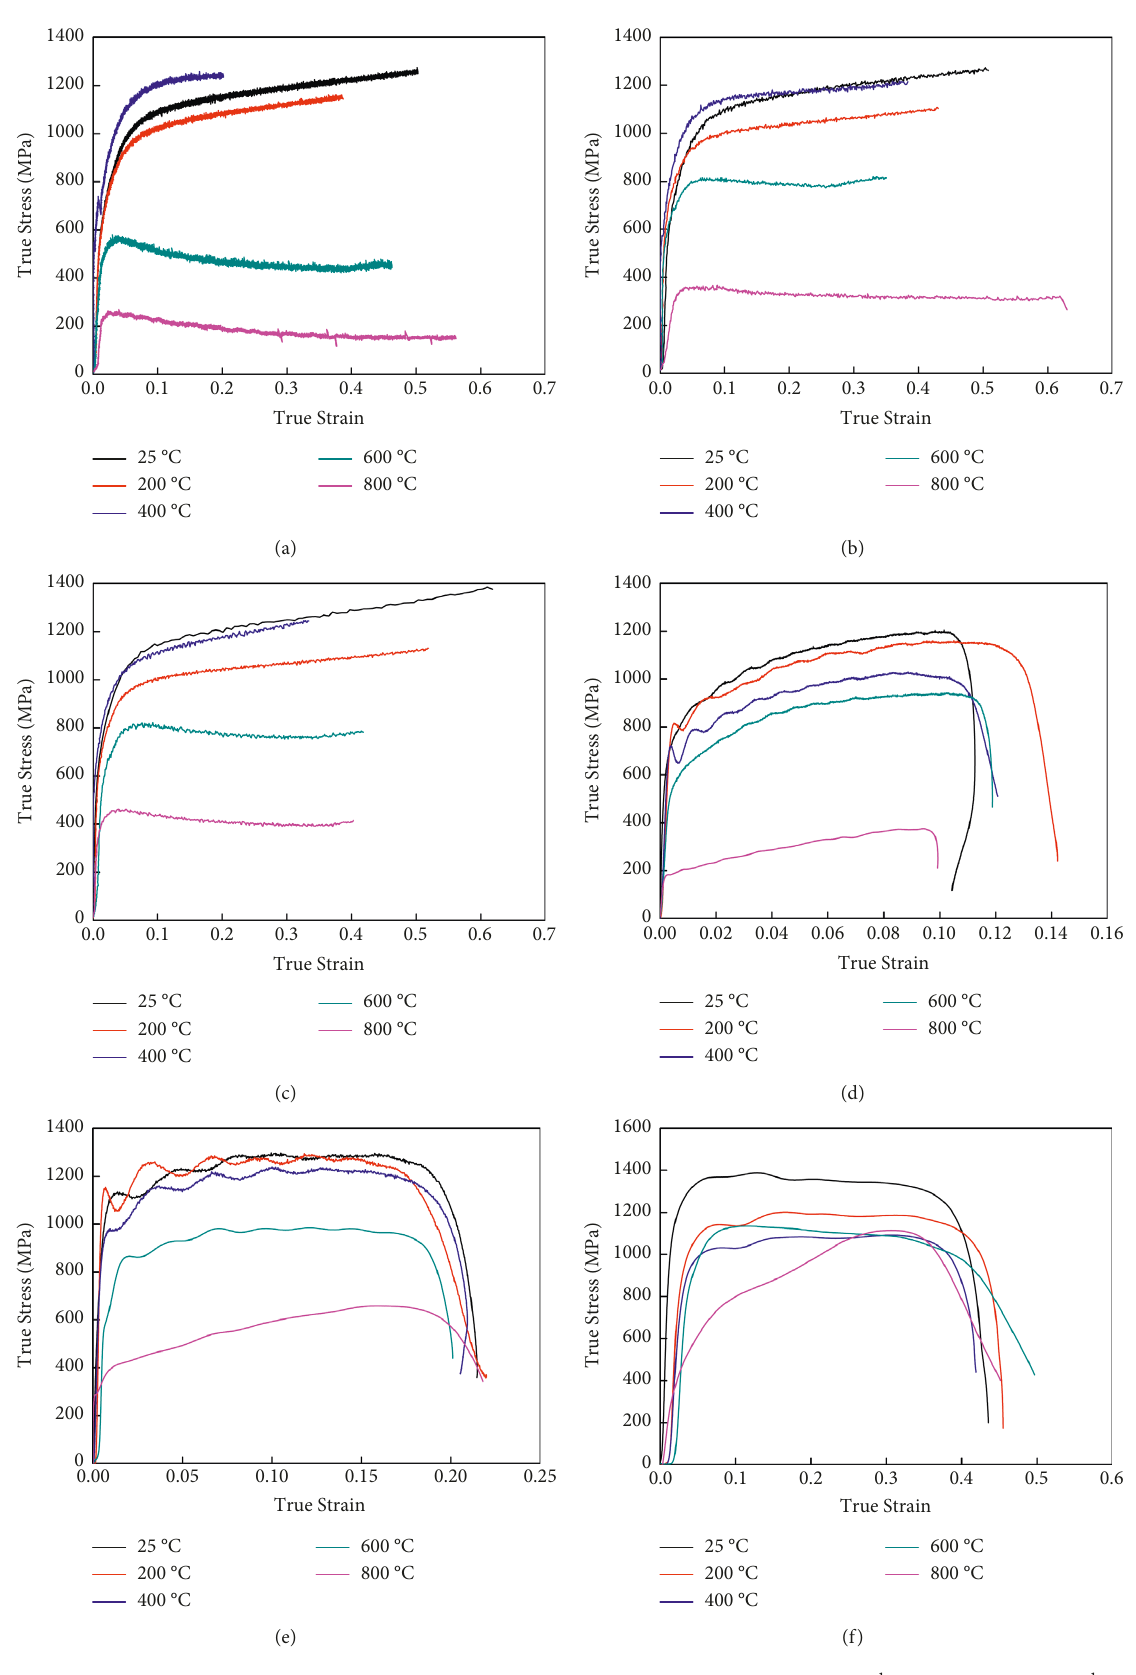
Figure 6: True stress-strain curves of U71Mn rail steel for different strain rates. (a) Strain rate: 0.0005s − 1 . (b) Strain rate: 0.01s − 1 . (c) Strain rate: 0.1s − 1 . (d) Strain rate: 800s − 1 . (e) Strain rate: 3000s − 1 . (f) Strain rate: 10000s − 1